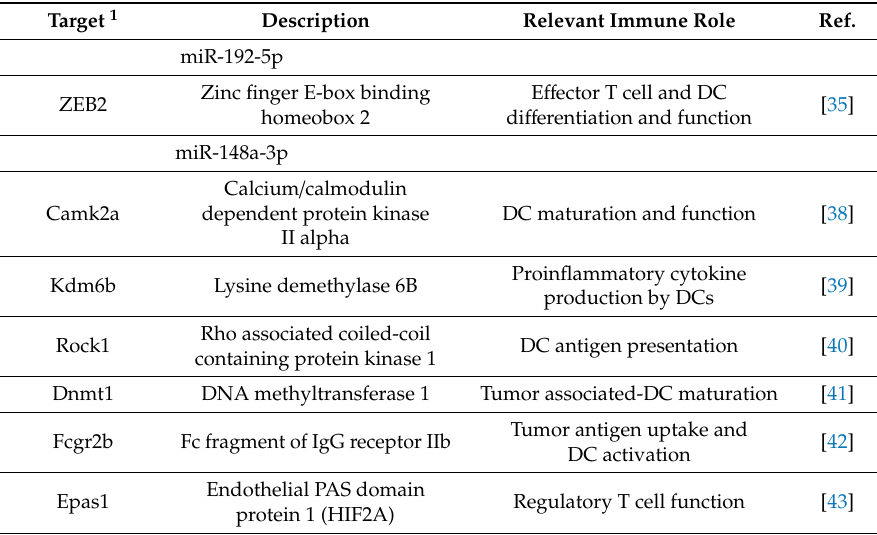
Figure 2. Human monocyte-derived dendritic cells and murine cytotoxic T lymphocytes acquire RNA molecules from hypoxic melanoma cells by a Cx43 gap junction-dependent mechanism. Mel3 human melanoma cells were cultured in normoxic (21% O 2 ; N) or hypoxic (1% O 2 ; H) conditions for 72 h, while B16F10 were cultured in the same conditions for 24 h. Intracellular RNA molecules were stained by cell incubation with SYTO RNASelect (green fluorescence dye; SytoRNA). Then, SytoRNA donor melanoma cells were co-cultured for 4 h with Violet BMQC [2,3,6,7-tetrahydro-9-bromomethyl-1H,5H-quinolizino(9,1-gh)coumarin)] pre-loaded human monocyte-derived dendritic cells (mo-DC) or pMEL-1 mouse cytotoxic T lymphocytes (CTL), respectively. Gap junction-mediated intercellular communications were inhibited using 50 µ M of carbenoxolone (CBX) or Cx43 inhibitory mimic peptide 1848 (respective controls: Ctrl). The acquisition of green-fluorescent RNA by immune cells was determined by flow cytometry. ( A ) Representative dot plots for a Mel3 / mo-DC co-culture. Violet BMQC + cells were gated and the percentage of SytoRNA + cells inside this population is shown. ( B ) The bar graphs show the percentage of Violet BMQC + immune cells (mo-DC or CTL, upper and lower) that acquired RNA molecules from N or H Mel3 or B16F10 cells, respectively. * p < 0.05; ** p < 0.01; **** p < 0.0001 (one-way ANOVA, Tukey’s multiple comparison test). Table 1. Experimentally validated murine miR-192-5p and miR-148-3p